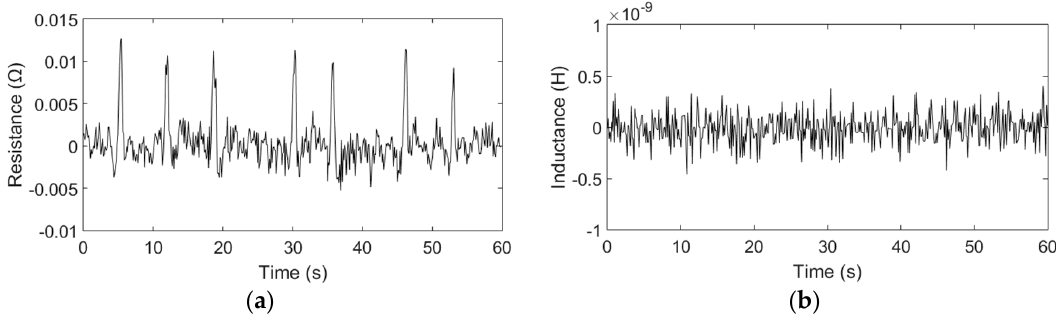
Figure 4. Detection results of the copper particles with sizes ranging from 48 μ m to 53 μ m: ( a ) Resistance detection results; ( b ) Inductance detection results.